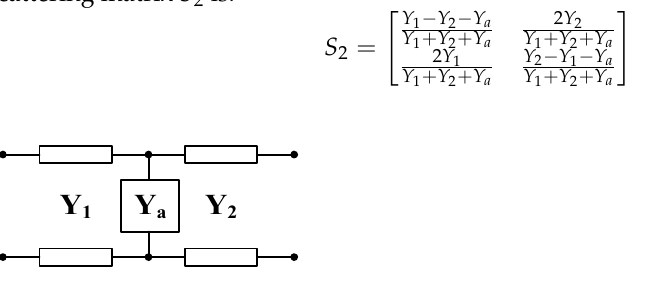
Figure 4. T-type equivalent two-port circuit.